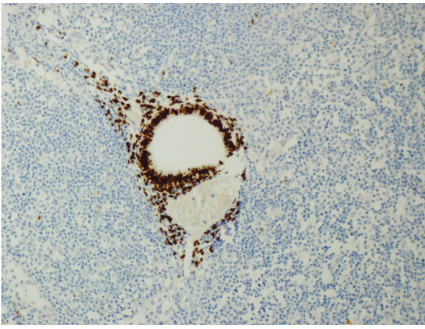
Figure 5: ER positivity of endometrial epithelial cells within lymph node (DAB, ×